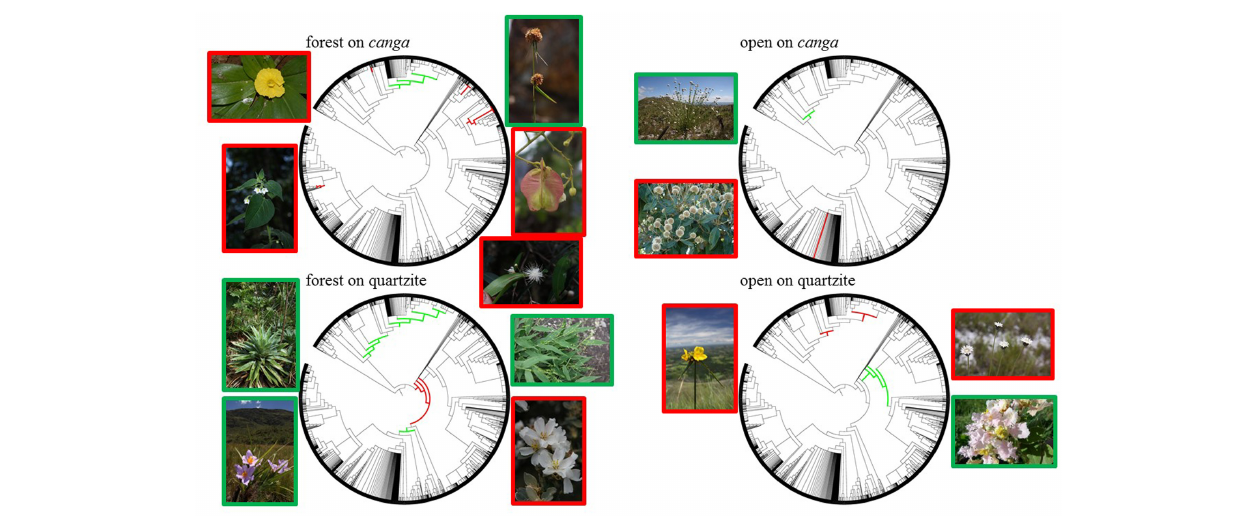
FIGURE 7 | Phylogenetic representations of the “Espinhaço megatree” summarizing over-represented and under-represented clades for each of the four vegetation:substrate types. Clades over-represented in a particular habitat type are shown in red, while under-represented clades are highlighted in green. Images of selected taxa for over-represented (framed in red) and under-represented (framed in green) clades are placed adjacent to each phylogeny as follows: forest on canga – Chamaecostus subsessilis (top left, photo by B. Klitgaard), Solanum didymum (bottom left, photo by W. Milliken), Rhynchospora exaltata (top right, photo by W. Milliken), Serjania paradoxa (middle right, photo by D. Zappi), Myrcia venulosa (bottom right, photo by W. Milliken); open on canga – Paepalanthus erectifolius (top left, photo by D. Zappi), Eremanthus incanus (bottom left, photo by P. L. Viana); forest on quartzite – Paepalanthus planifolius (top left, photo by W. Milliken), Vellozia glabra (bottom left, photo by W. Milliken), Panicum sellowii (top right, photo by W. Milliken), Trembleya laniflora (bottom right, photo by D. Zappi); open on quartzite – Cephalostemon riedelianum (left, photo by W. Milliken), Paepalanthus comans (top right, photo by D. Zappi), Banisteriopsis malifolia (bottom right, photo by W.